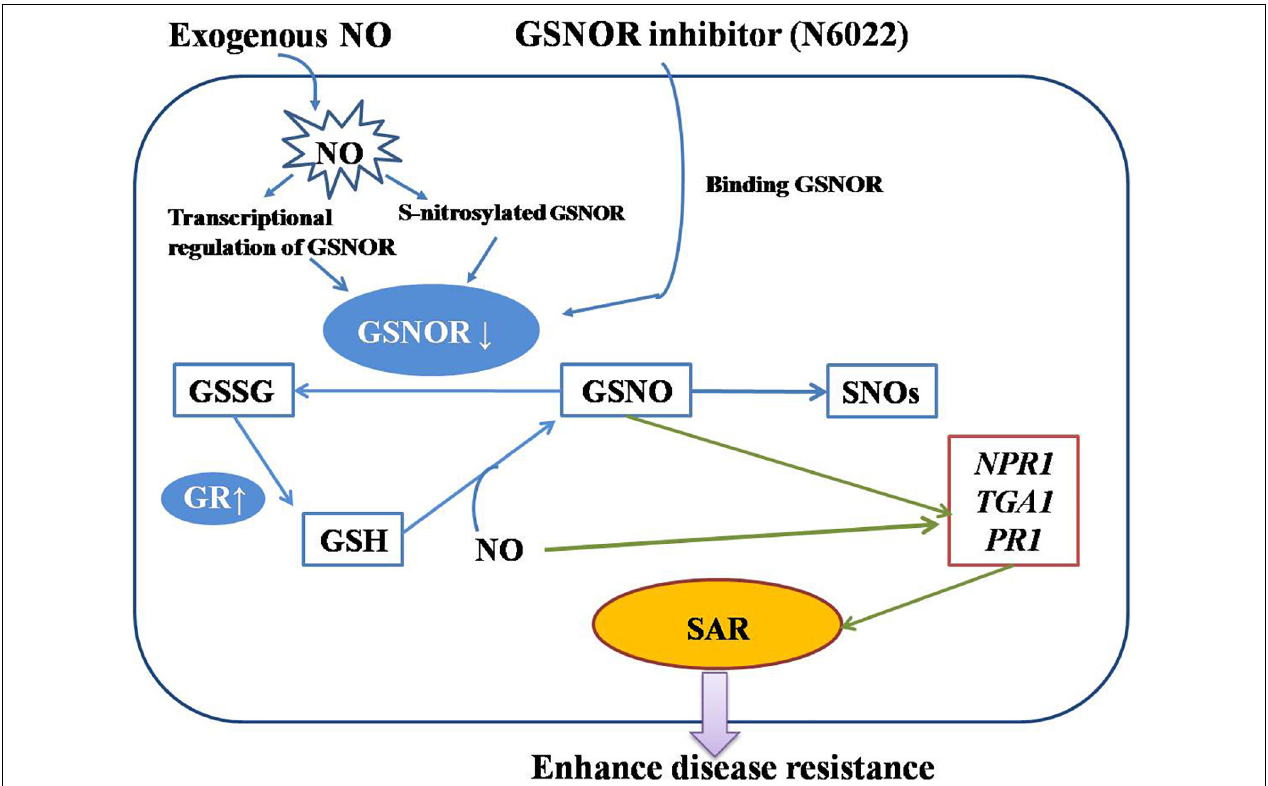
FIGURE 7 | A diagram of the action mechanism of exogenous nitric oxide (NO) and N6022 on improving disease resistance of peach fruits made according to our research.